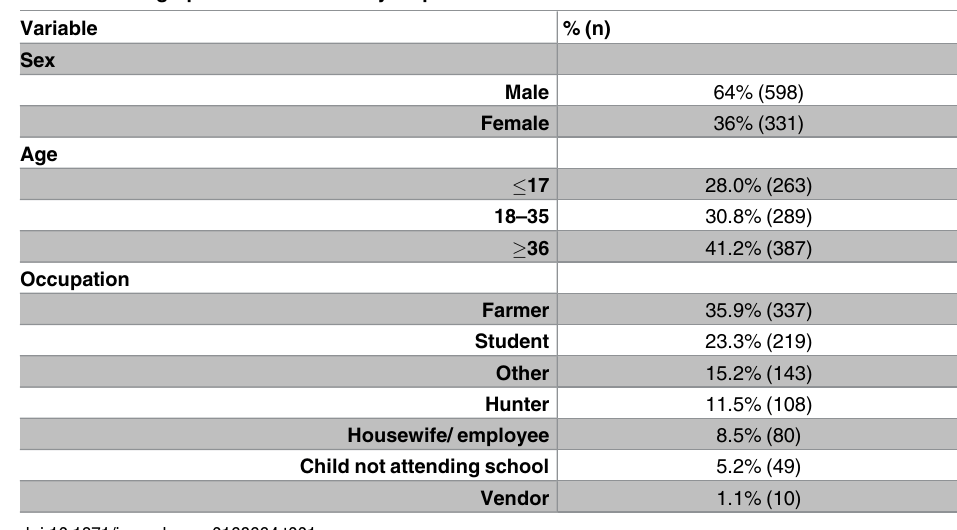
Table 1. Demographic data from survey